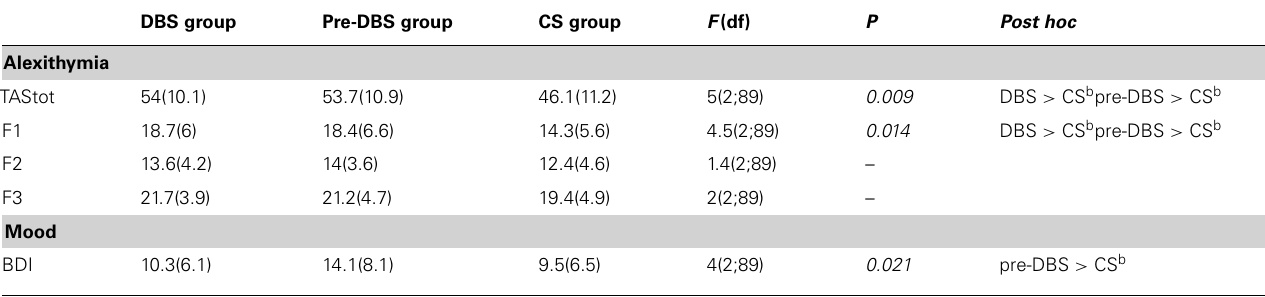
Table 2 | Comparison of alexithymia and mood (BDI) between the DBS, pre-DBS, and C groups. DBS